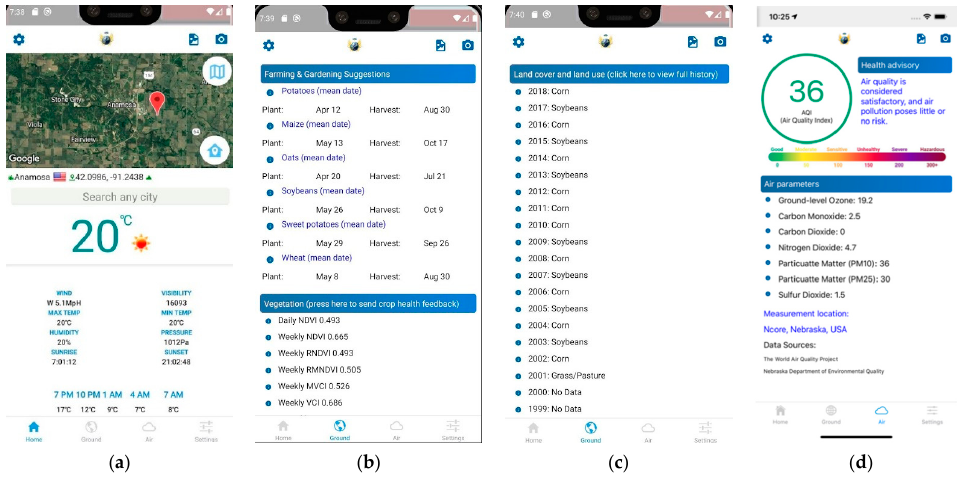
Figure 5. Screenshots of GeoFairy2 ( a ) home panel; ( b ) farming advice and vegetation status; ( c ) land cover history, and ( d ) air quality. Figure 5b,c are taken from the Ground panel. The farming suggestion section gives